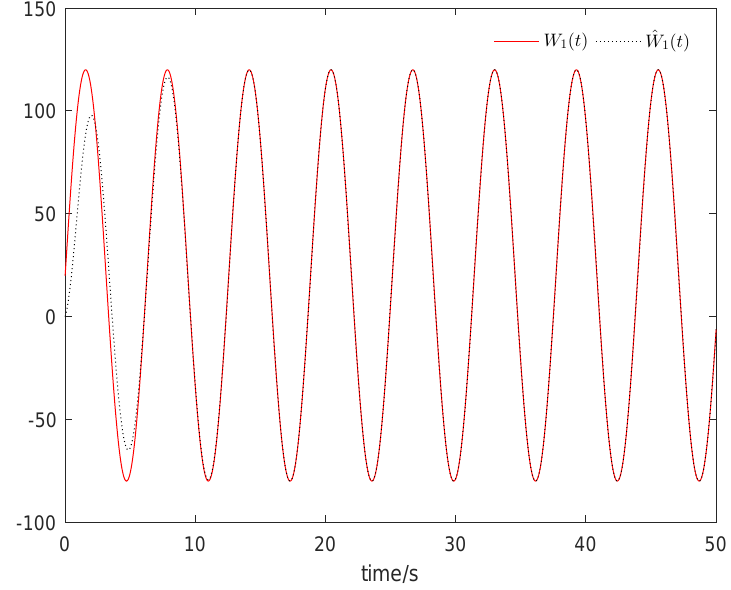
Figure 7. ˆ W 1 ( t ) tends to W 1 ( t ) .